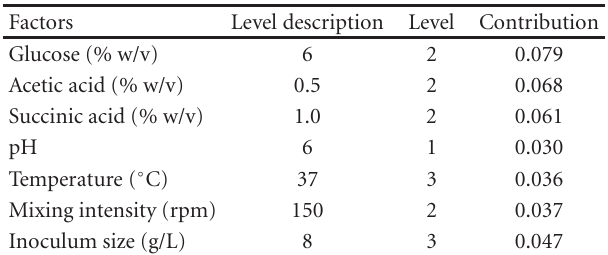
Table 6: The optimal conditions and their performance